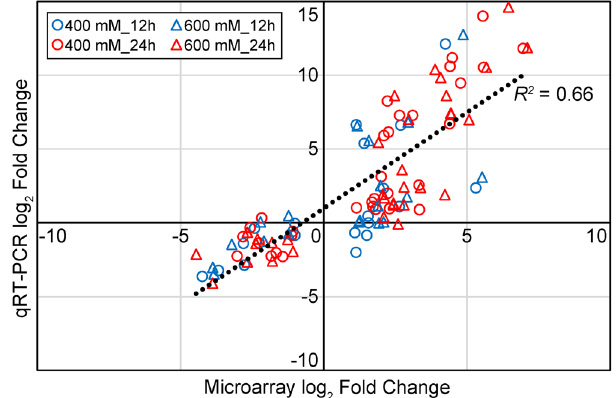
Figure 8. Validation of microarray data using qRT-PCR. Total of 38 genes were selected for qRT-PCR validation. The samples treated after 12 h and 24 h using 400 mM or 600 mM NaCl were compared with control. x -axis indicates log2 fold changes from microarray data and y -axis indicate log2 fold changes from qRT-PCR results. The coefficient of determination ( R 2 ) between microarray results and qRT-PCR results was